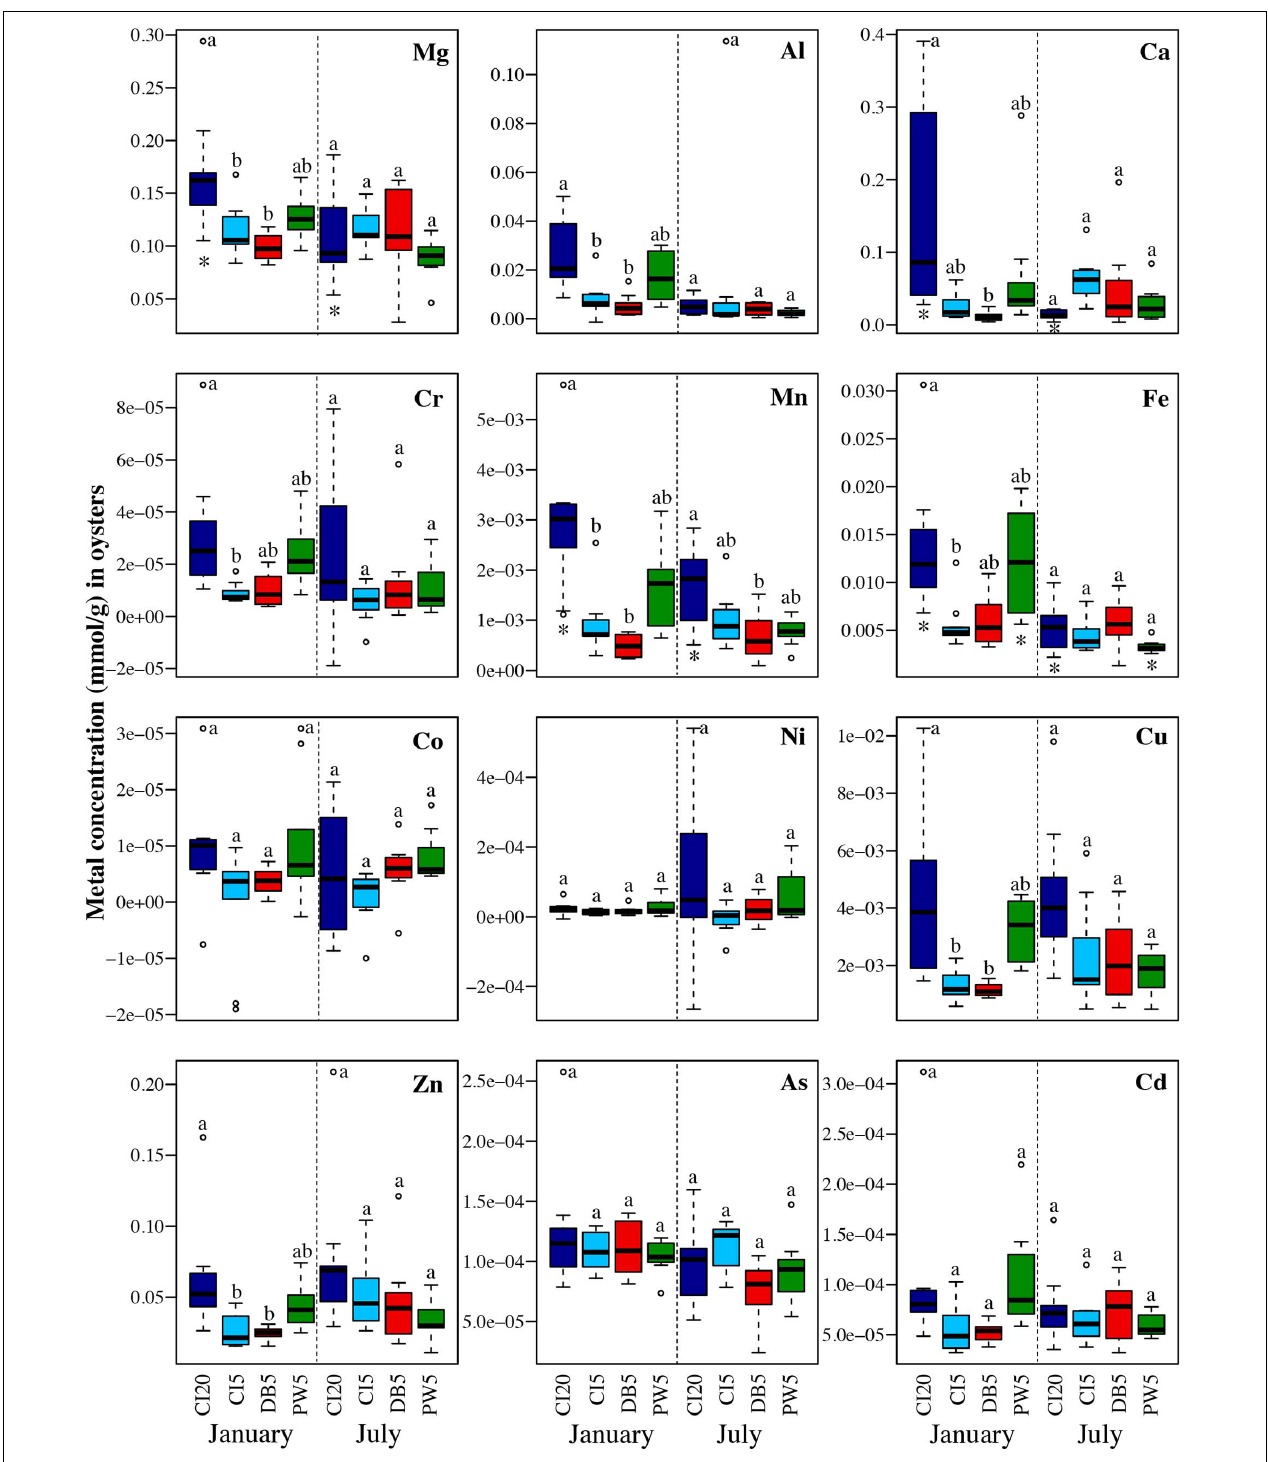
FIGURE 8 | Concentrations in mmol/g for each of the twelve analyzed trace metals in oysters held for 6 months (January) and 1 year (July) in four locations: Carr Inlet 20 m (dark blue), Carr Inlet 5 m (light blue), Dabob Bay 5 m (red), and Point Wells 5 m (green). ANOVAs and Tukey Post-Hoc Tests with a Bonferroni correction were used to see if there were significant differences (alpha of 0.004) between location for January and July separately , and differences are indicated by letter above each boxplot. Separate ANOVA and Tukey Post-Hoc Tests were also completed to compare across time periods. Asterisks below the box plot indicate a significant difference (alpha of 0.004) in the concentration of a metal at one site between January and July .